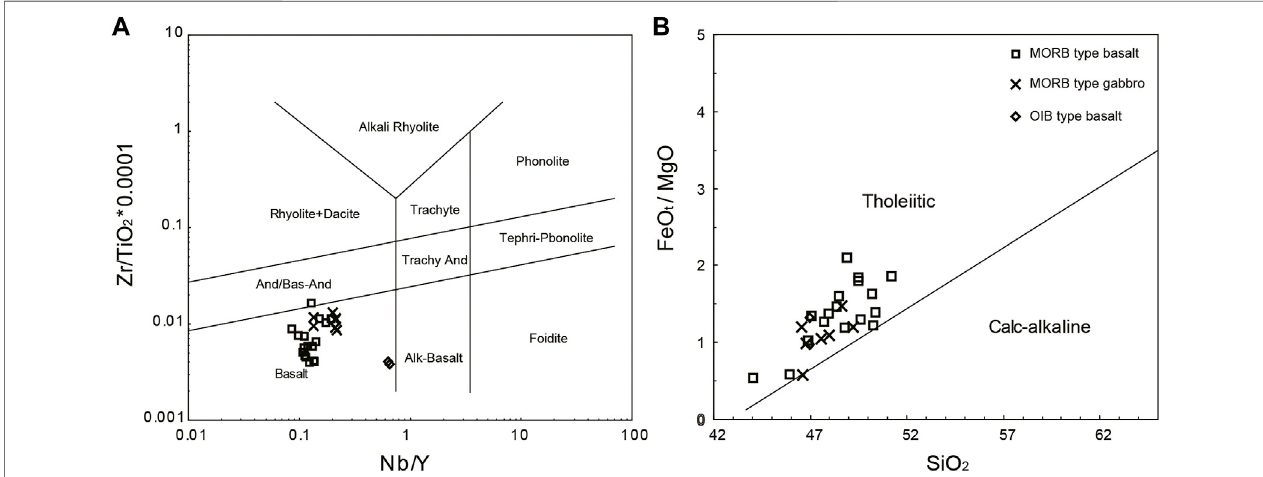
FIGURE 8| Geochemical classi fi cation diagrams of the Huaniushan complexin the Beishan orogen, NW China. (A) Zr/Ti vs. Nb/Y diagram (Winchester and Floyd, 1977) and (B) FeO t /MgO vs. SiO 2 diagram (Myashiro,